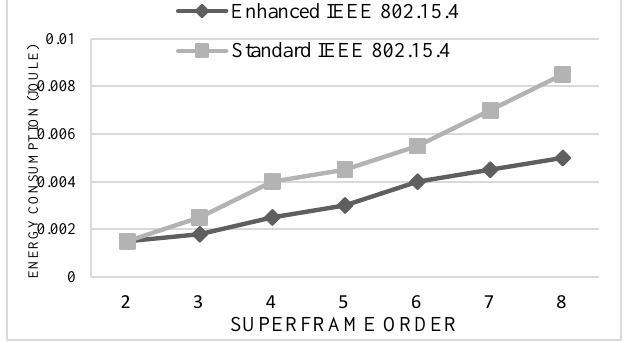
Fig. 7. Comparison between average energy consumption resulted from the original and enhanced standard 6.5 Delay in IEEE 802.15.4